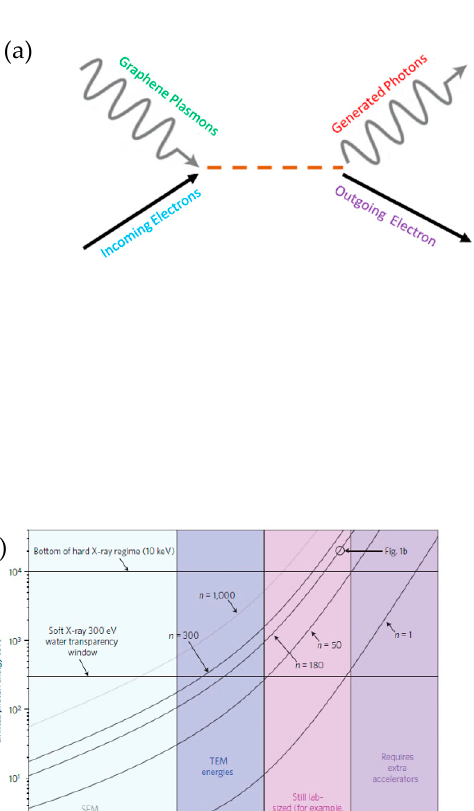
z -axis, which is in the direction of the hot carrier motion